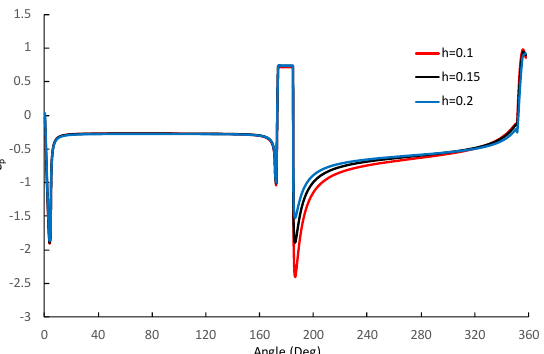
Figure 13. Comparison of pressure distributions on the trains with different ground clearance.